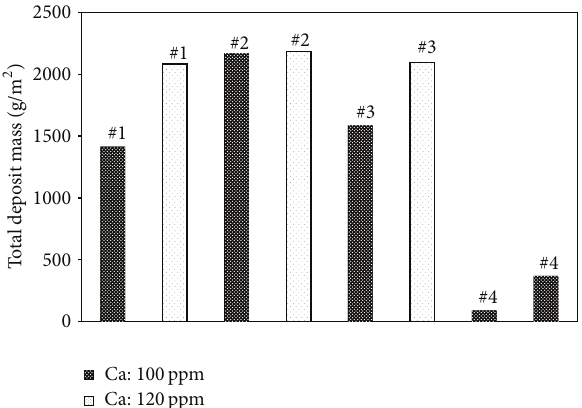
Figure 8: Total amount of the deposit mass in the PHE per unit area for 1% (w/w) WPI fouling solutions at various calcium concentrations (100 and 120ppm) and for different temperature profiles (# 𝑖 corresponds to the thermal profile number given in Figure 4 and Table 2).